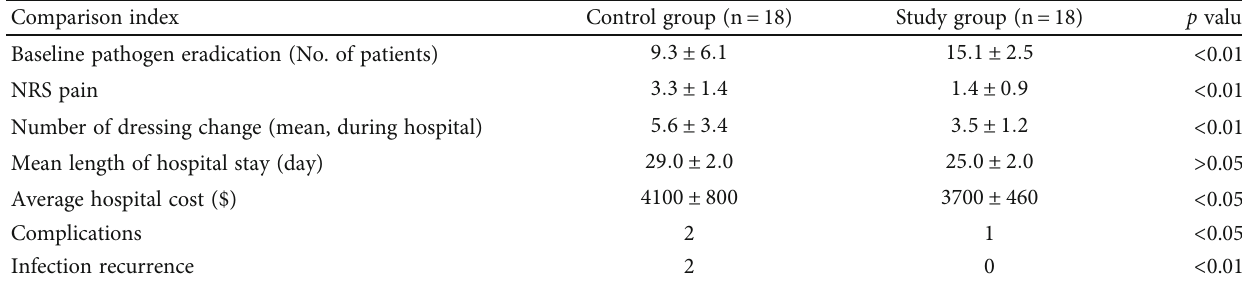
Table 3: Comparison of patients postoperative clinical outcomes.